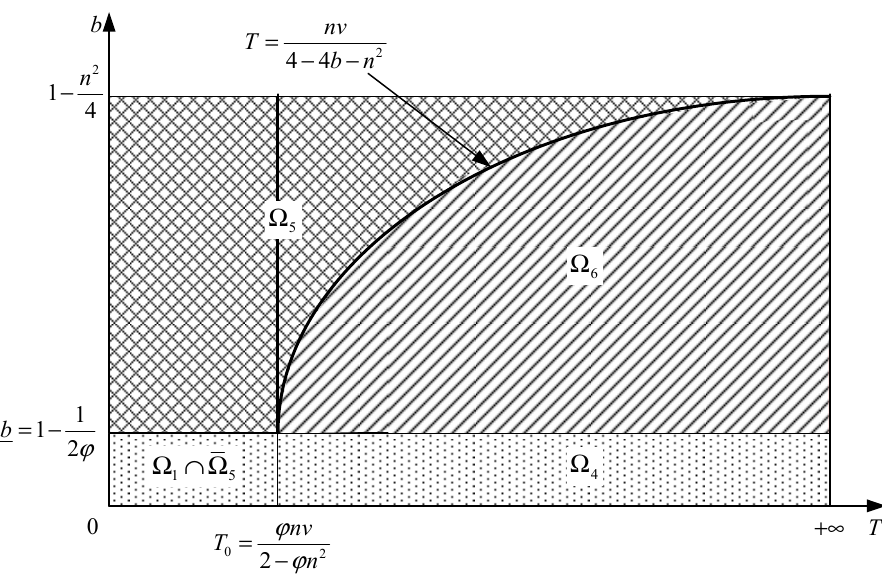
Figure 2. Division of decision space with a dominant retailer.